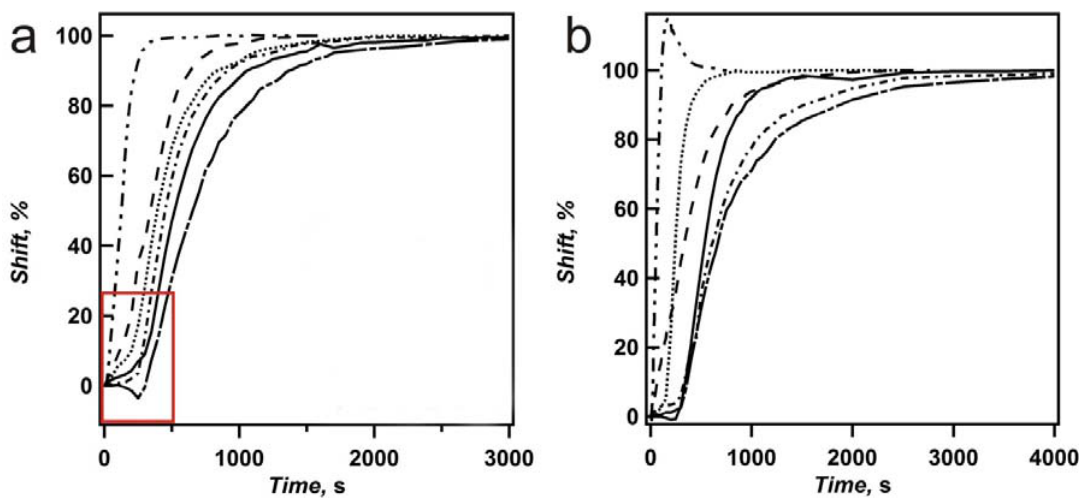
Figure 5. Deswelling curves for two different sets of etalons ( a , b ), made of the same microgels, using the same painting method. The percent shift of the high wavelength peak in the reflectance spectrum is plotted as a function of time. Plots shown are: 5 nm ( − · · − ), 10 nm ( − − − ), 15 nm (···), 20 nm (solid), 25 nm ( − · − ), and 35 nm (— - —). Deswelling was induced by introducing a 30% (v/v) MeOH/water solution (2 mM I.S.) held at 25 °C. Reprinted with permission from [14] Copyright (2011) American Chemical Society.